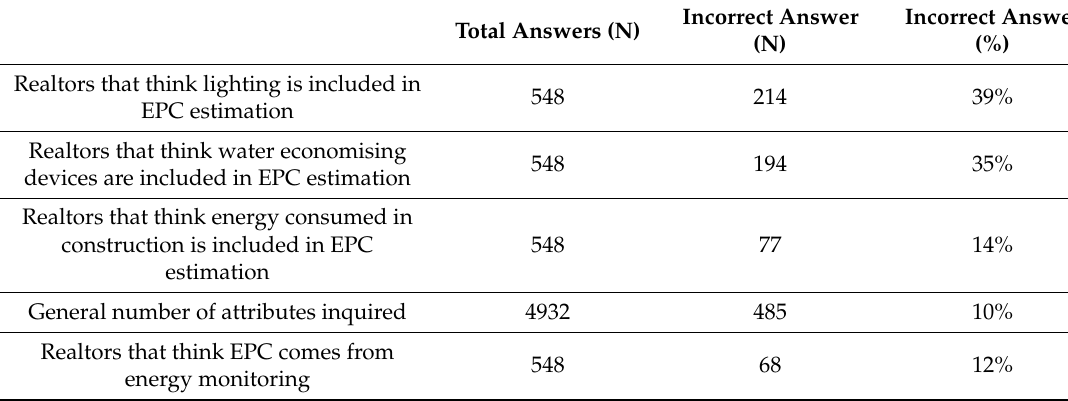
Table 4. Realtors’ knowledge of the attributes a ff ecting EPC